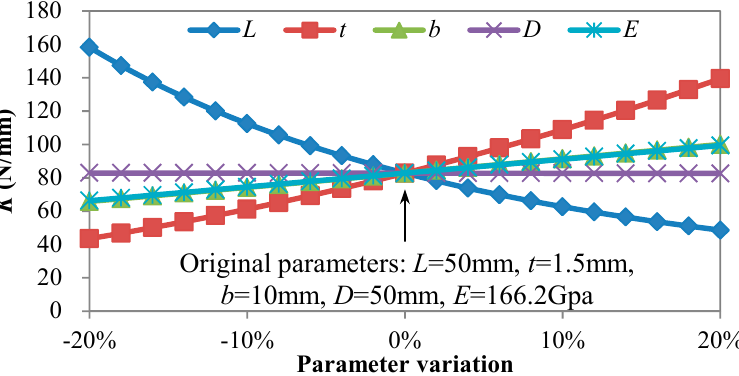
Figure 6. Parameter study of the flexure parallel mechanism through finite element analysis.